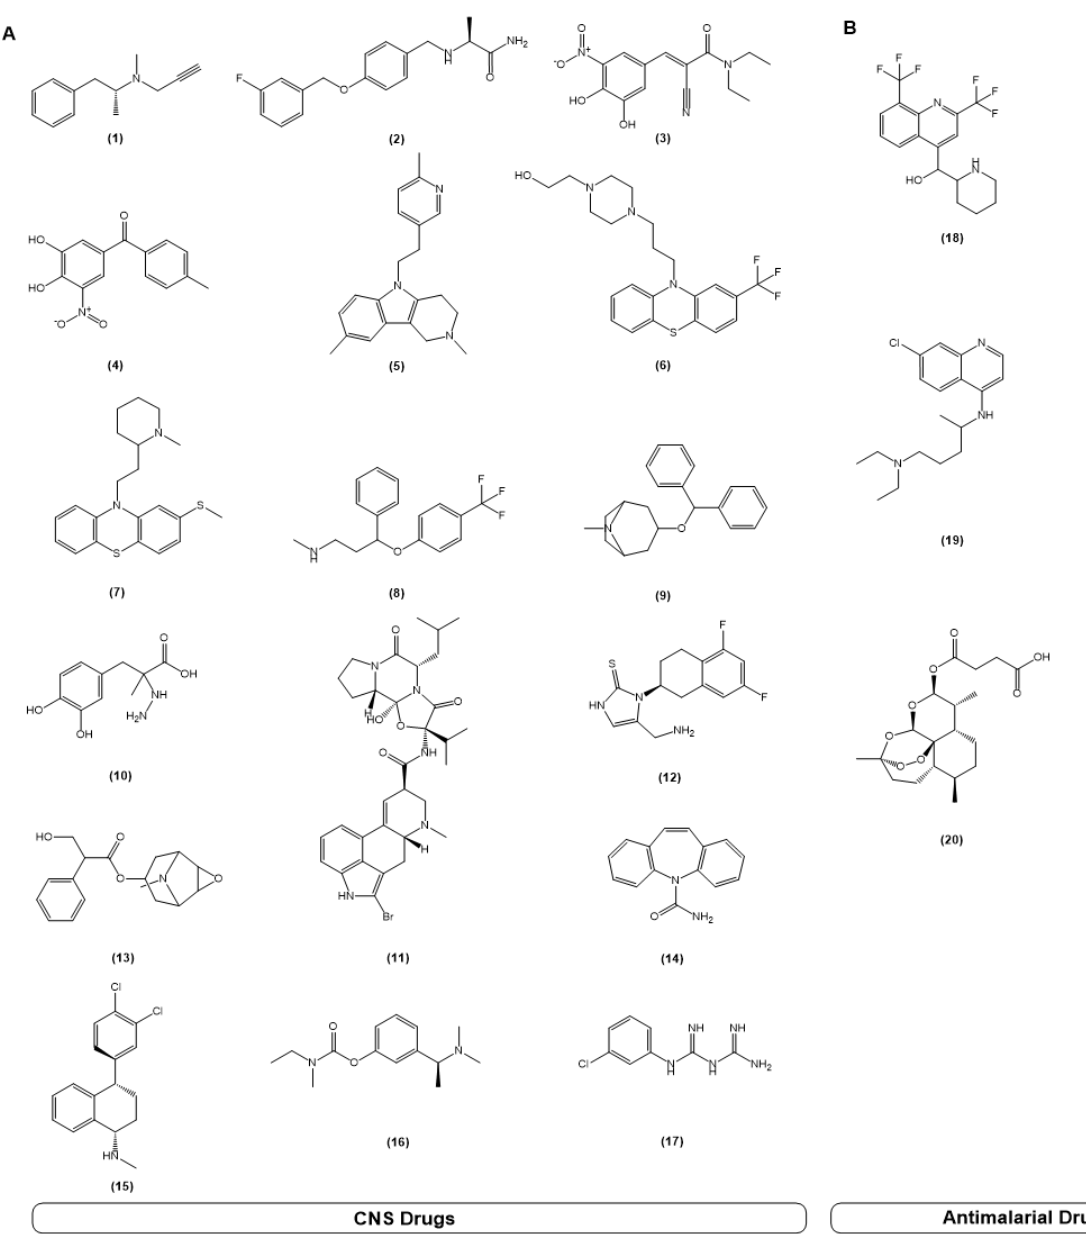
Table 1. CNS drugs used in this work and their mechanism of action. Drug Mechanism of Action Ref. Irreversible inhibitor of monoamine oxidase type B (MAO-B). Binds to MAO-B and blocks the microsomal metabolism of dopamine, enhancing Selegiline the dopaminergic activity in the substantial nigra. It can also inhibit monoamine oxidase type A (MAO-A). Reversible inhibitor of MAO-B; blocks voltage-dependent Na + and Ca 2+ Safinamide channels and inhibits the glutamate release.